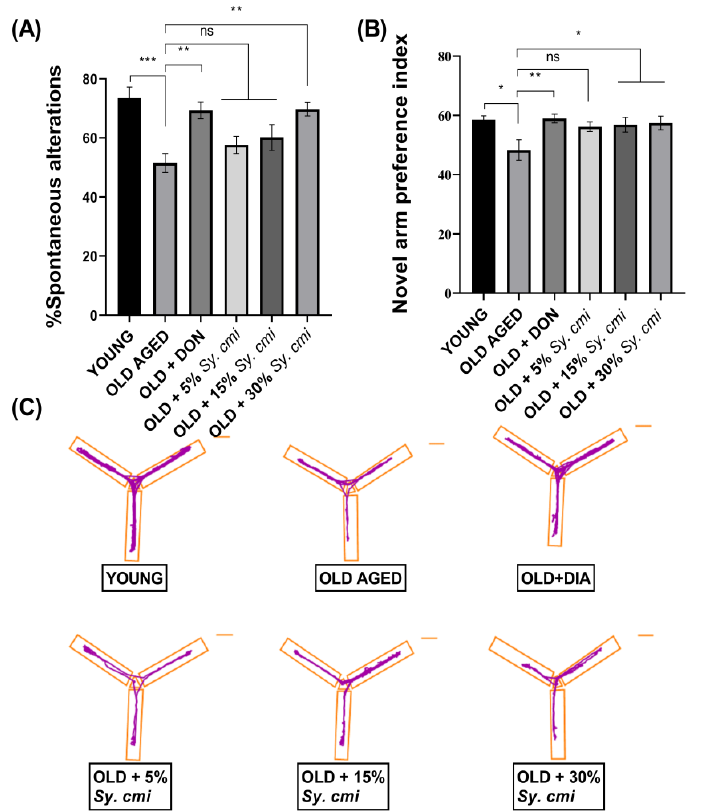
Figure 5. The mice ( n = 8) supplemented with 5, 15, and 30% dilutions of Sy. cmi for 16 months were tested for learning and memory in T-maze and Y-maze tests, and their activity in the maze for 5 min was evaluated for ( A ) % spontaneous alteration, ( B ) novel arm preference index, and ( C ) representative track plots of animals’ activity in the Y-maze. The outcomes of all groups were compared with the aged control group and * p < 0.05,** p < 0.01, *** p < 0.001 were considered statistically significant while ns showed non-sgnificant outcomes for all data presented as mean ±